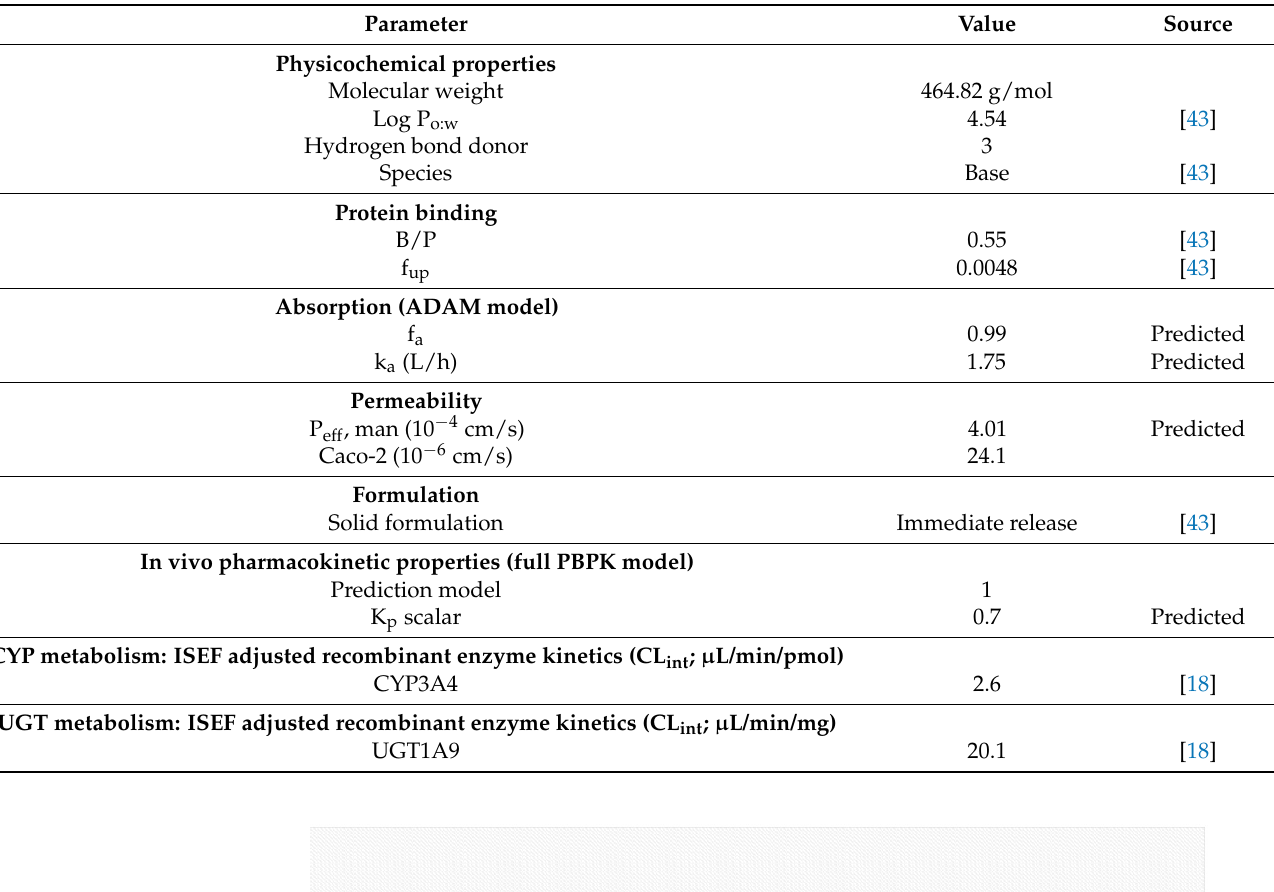
Table 4. Model inputs used to build the sorafenib compound model.